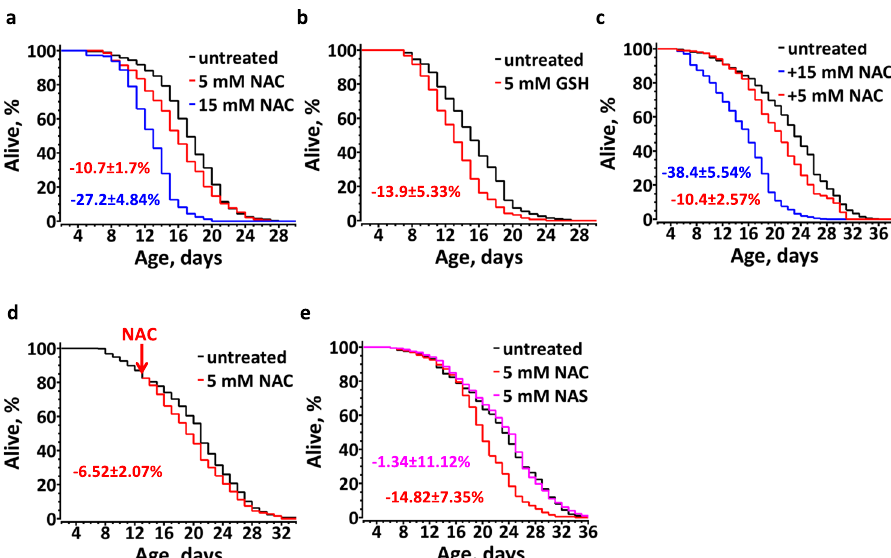
Fig. 1 Thiol antioxidants shorten C. elegans lifespan. Chronic supplementation of fresh NAC ( n = 234(untreated), 159(5 mM NAC), 223(15 mM NAC)), ( a ) or GSH ( n = 175(untreated), 168(5 mM GSH)), ( b ) limits the lifespan of live bacteria (LB)-fed C. elegans . c NAC dose-dependently shortens the lifespan of dead bacteria (DB)-fed C. elegans ( n = 525(untreated), 263(5 mM NAC), 211(15 mM NAC)). d Supplementation of NAC to older animals mildly shortens their lifespan. N2 animals were fed DB until day 13 of adulthood; half of them were transferred to agar plates with 5 mM NAC ( n = 261(untreated), 289(5 mM NAC)). e The SH-group of NAC accounts for accelerated aging. Worms fed DB treated with N-acetyl serine (NAS), which has an – OH, instead of a – SH ( n = 203(untreated), 204(5 mM NAC), 221(5 mM NAS)). All graphs show the composite of three independent experiments (except b , which is a composite of two independent experiments). Average percentage change ±SD of the lifespan relative to an untreated control is indicated in color matching the corresponding curve. See also Supplementary Table